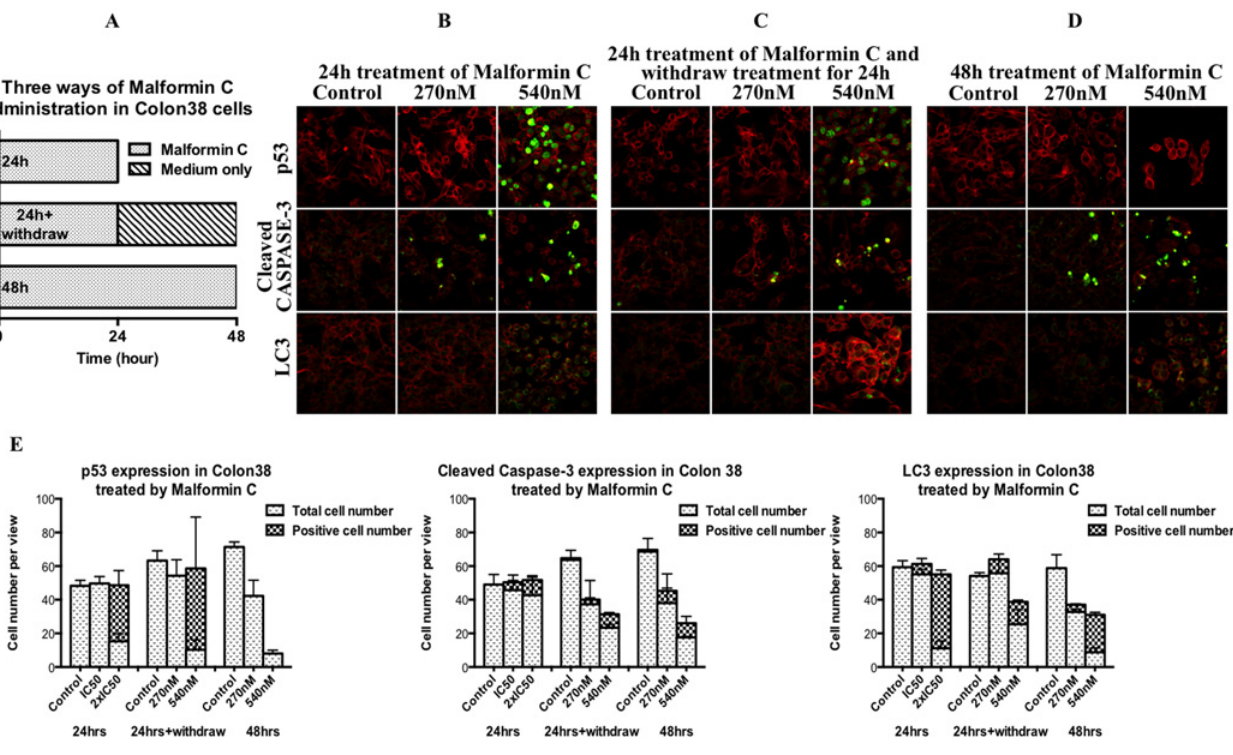
Fig 2. Immunofluorescence micrographs of the p53, cleaved CASPASE 3 and LC3 in Malformin C treated Colon 38 cells. The expression level (green fluorescence) was probed with specific monoclonal p53, cleaved CASPASE 3 and LC3 antibodies respectively, followed by FITC-conjugated anti-mouse IgG. Cytoplasmic Actin (red fluorescence) was counterstained with rhodamine phalloidin. Immunofluorescence micrographs are taken by confocal microscope. (A) Experiment design-Malformin C was given for 24h and stained at 24h, for 24h and stained at 48h, for 48h and stained at 48h, respectively. (B) Immunofluorescence staining at 24h after 24h treatment. (C) Immunofluorescence staining at 48h after 24h treatment. (D) Immunofluorescence staining at 48h after 48h treatment. (E) Expression of p53, cleaved CASPASE 3 and LC3 after three ways of administration of different concentration of Malformin C based on confocal microscopy